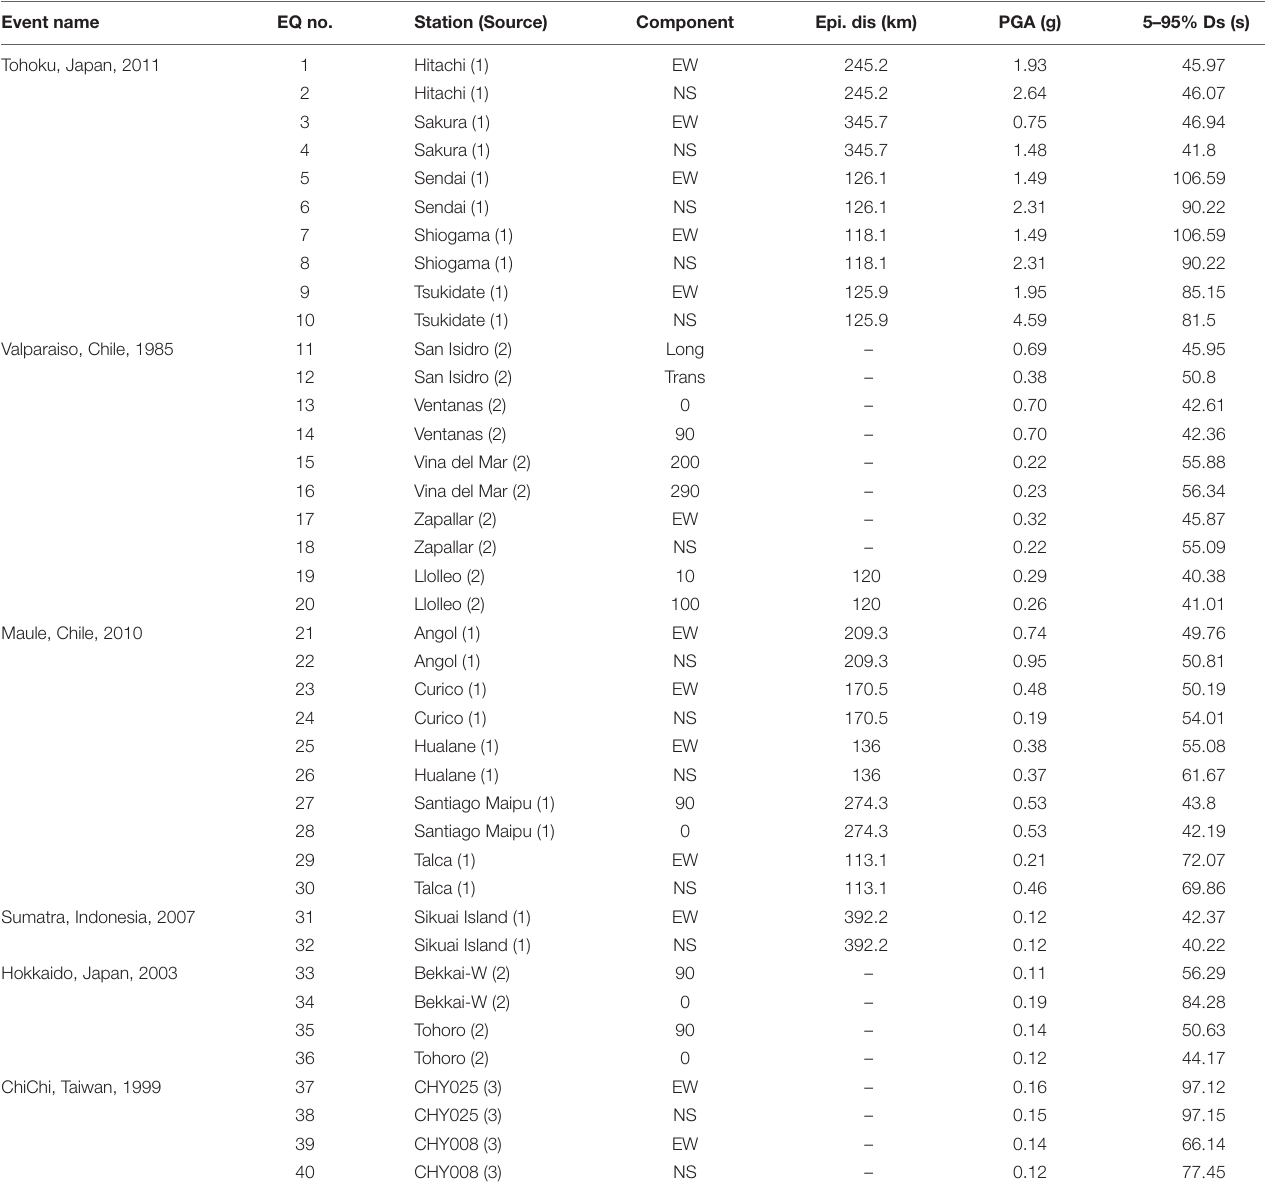
TABLE 1 | List of long duration